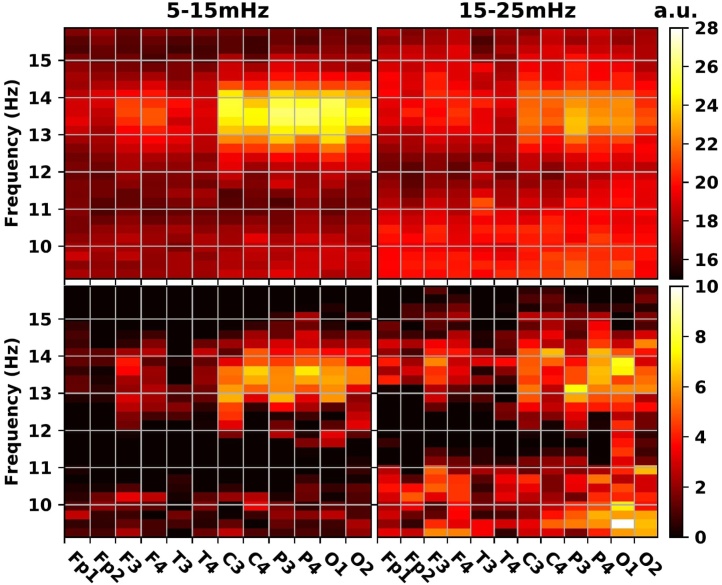
Relative infra power spectral density of the sigma band (9–16 Hz) (see Fig. 2) integrated over the 5–15 mHz (left column) and 15–25 mHz (right column) infra range, respectively, as function of signal frequency and topography. Top heatmaps represent infra powers obtained by averaging across 34 subjects (baseline stage 2 sleep, contralateral referencing). Bottom row contains the corresponding Bonferroni corrected ((16 Hz – 9 Hz)/0.25 Hz × 12 channels = 336 multiplier) P-values from one-sample t-tests. The mean infra power level (flat spectrum) was used as null hypothesis. Color coding follows the 0.05/P-value ratio on base 10 logarithmic scale. Lack of significance appears in black.